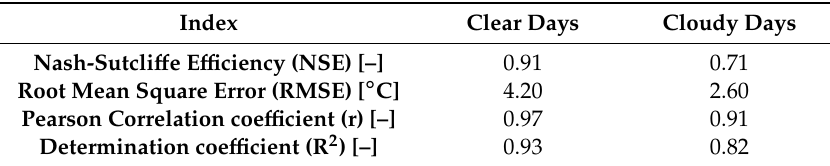
Table 10. Statistical indexes during clear and cloudy sky days between observed and forecasted LST values by the MEC algorithm.